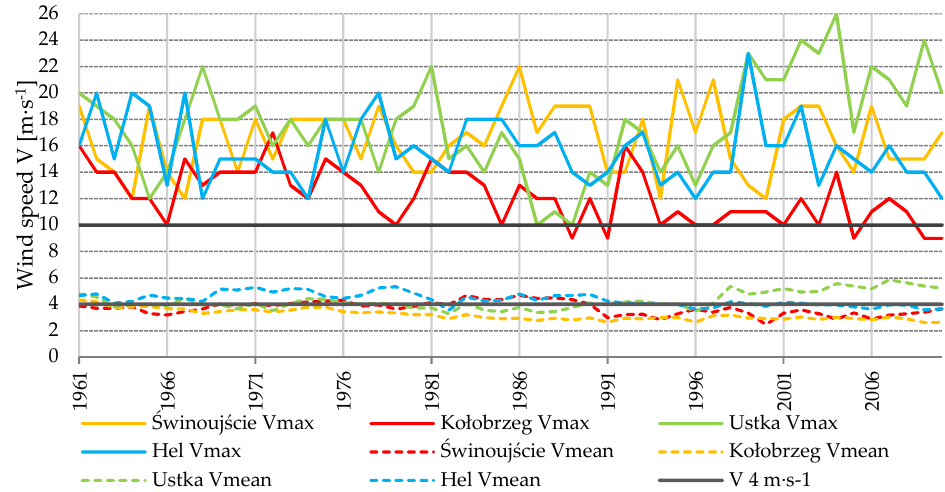
Figure 2. Annual dynamics of wind speed in the Polish Baltic coastal zone.